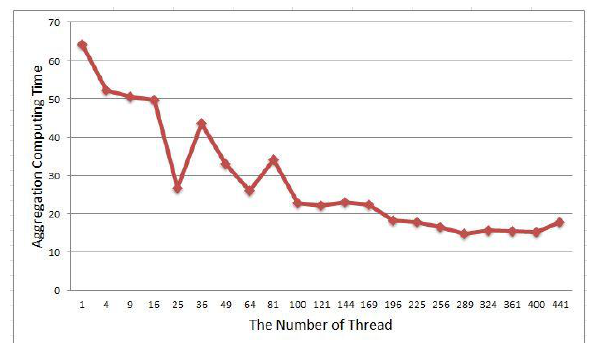
Figure 9. The experimental result of multi-thread parallel technique on dataset